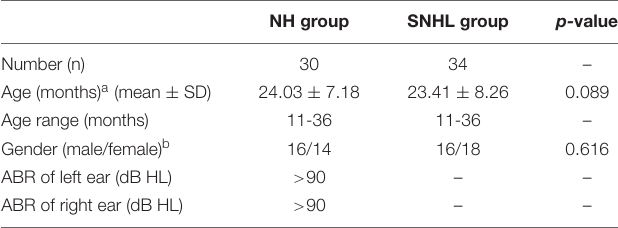
TABLE 1 | Summary of the demographic and clinical